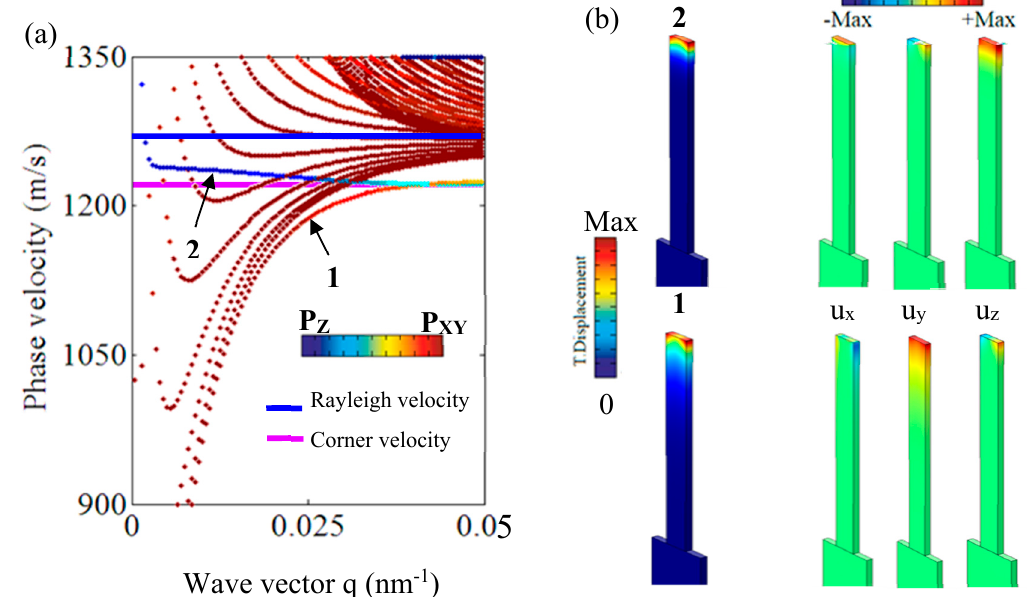
Figure 4. ( a ) Phase velocity diagram as a function of the wave vector where the blue solid line represents the Rayleigh wave velocity of epoxy, and the pink solid line represents the edge wave velocity. The modes have been selected as a function of their polarization following Equations (1) and (2). The red (resp. blue) color corresponds to the polarization P xy (resp. P z ) ( b ) Displacement field maps of the two edge modes ‘1 ′ and ‘2 ′ at the wave vector q = 0.02 nm − 1 .